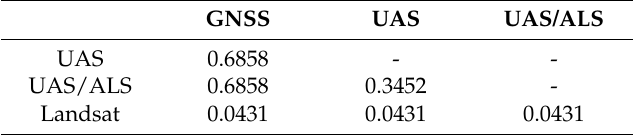
Table 2. The p -values of the Wilcoxon paired test for used methods and GNSS measurements.